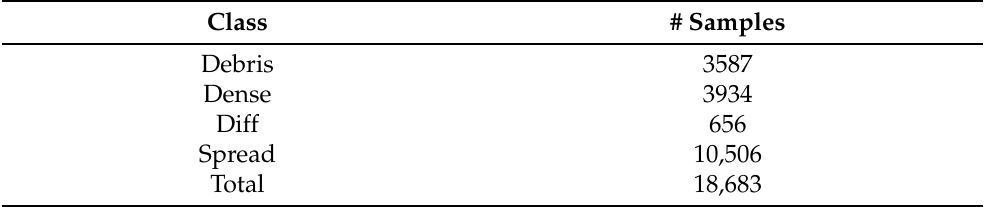
Table 5. Data breakdown for four morphological classes. Class imbalances observed here are a factor of the natural growth and differentiation cycle of the